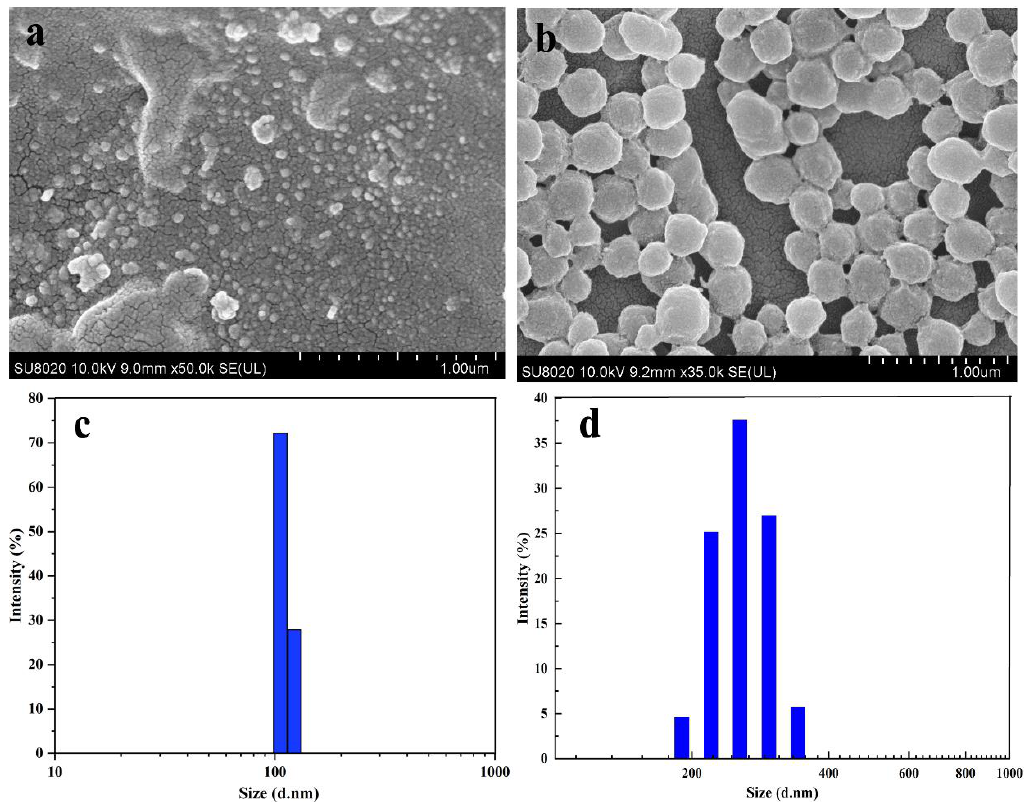
Figure 3. FE-SEM images of ( a ) CS-NP and ( b ) CS-CEO, at a CEO to CS weight ratio of 0.39:1 and magnification of 1.0 × 10 6 . Particle size distribution of ( c ) CS-NPs and ( d ) CS-CEO loaded at a CEO to CS weight ratio of 0.39:1.